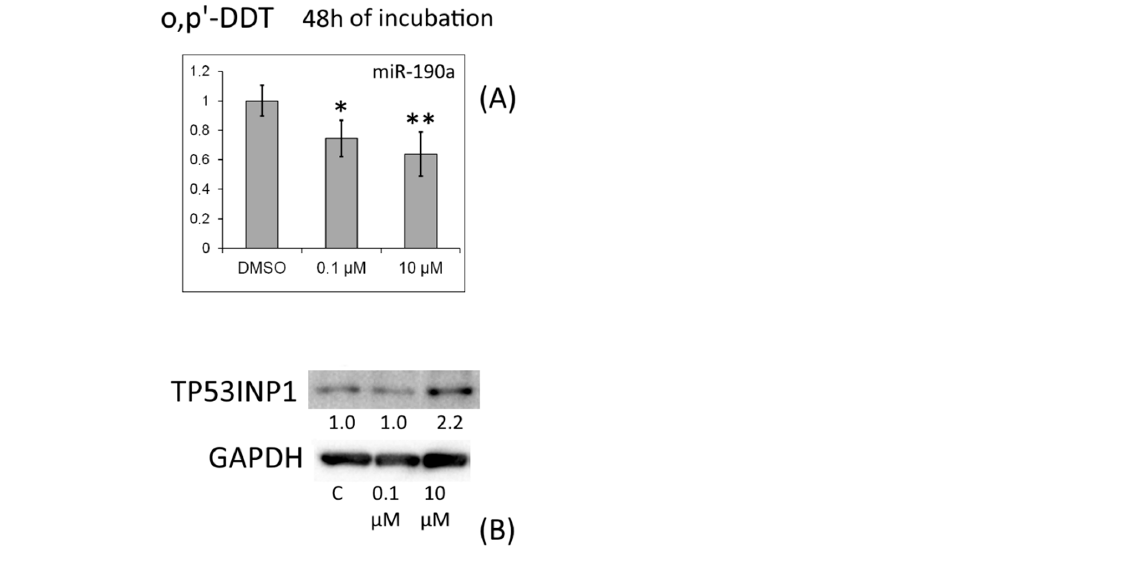
The numbers under TP53INP1 bands denote fold change in the protein level as compared to the